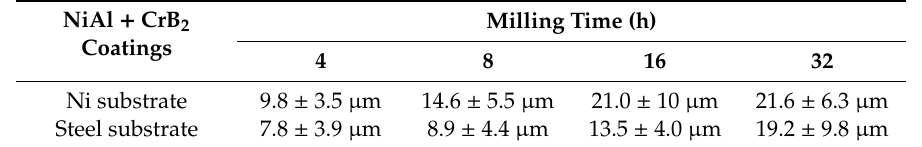
Table 1. Average thickness of coatings on nickel and steel substrates obtained after various milling